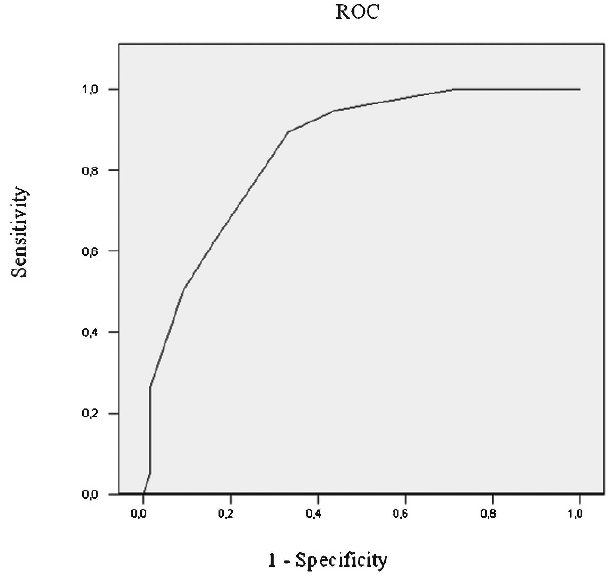
Table 2 - The results of logistic-regression analyses assessing the individual effects of GA, antenatal corticosteroid treatment, maternal pre-eclampsia and chorioamnionitis on the SF-BPD rate in the nCPAP and INSURE groups. The SF- BPD rate in both these groups was significantly higher than in the prolonged-mechanical-ventilation group.